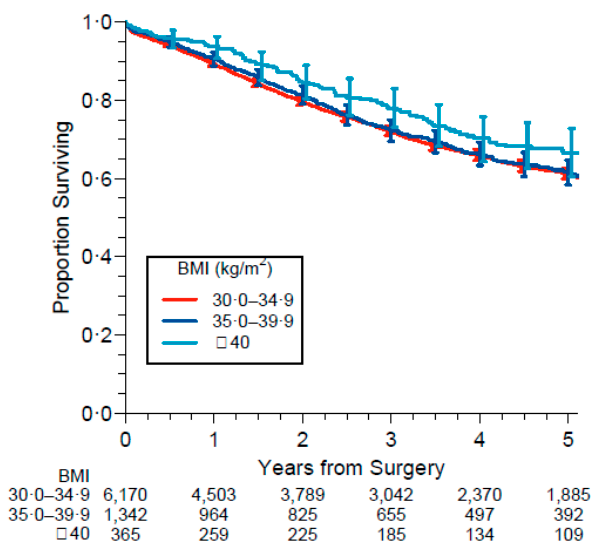
Figure 5. Survival according to obesity categories. Obesity classes are defined as class 1: BMI 30.0 – 34.9, class 2: BMI 35.0–39.9 and class 3: BMI ≥ 40.0. 30.0–34.9, class 2: BMI 35.0–39.9 and class 3: BMI ≥ 40.0.